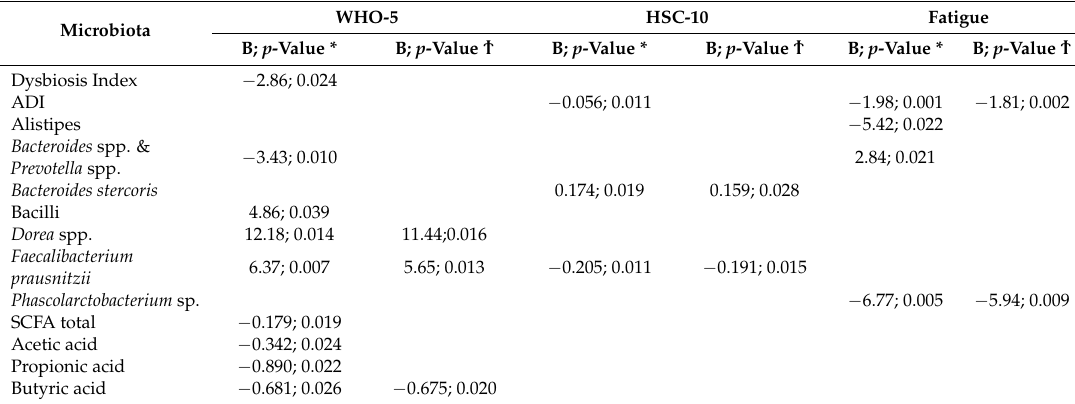
Table 3. The significant associations between the psychological disorders and the faecal microbiota and SCFA. Regression analyses with the psychological variables as dependent variables.